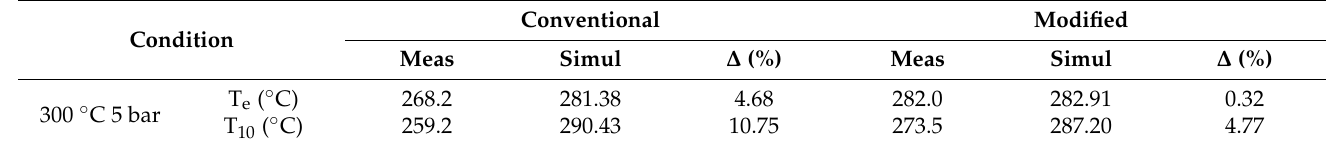
Table 2. Gas temperature obtained from CFD simulations and experimental